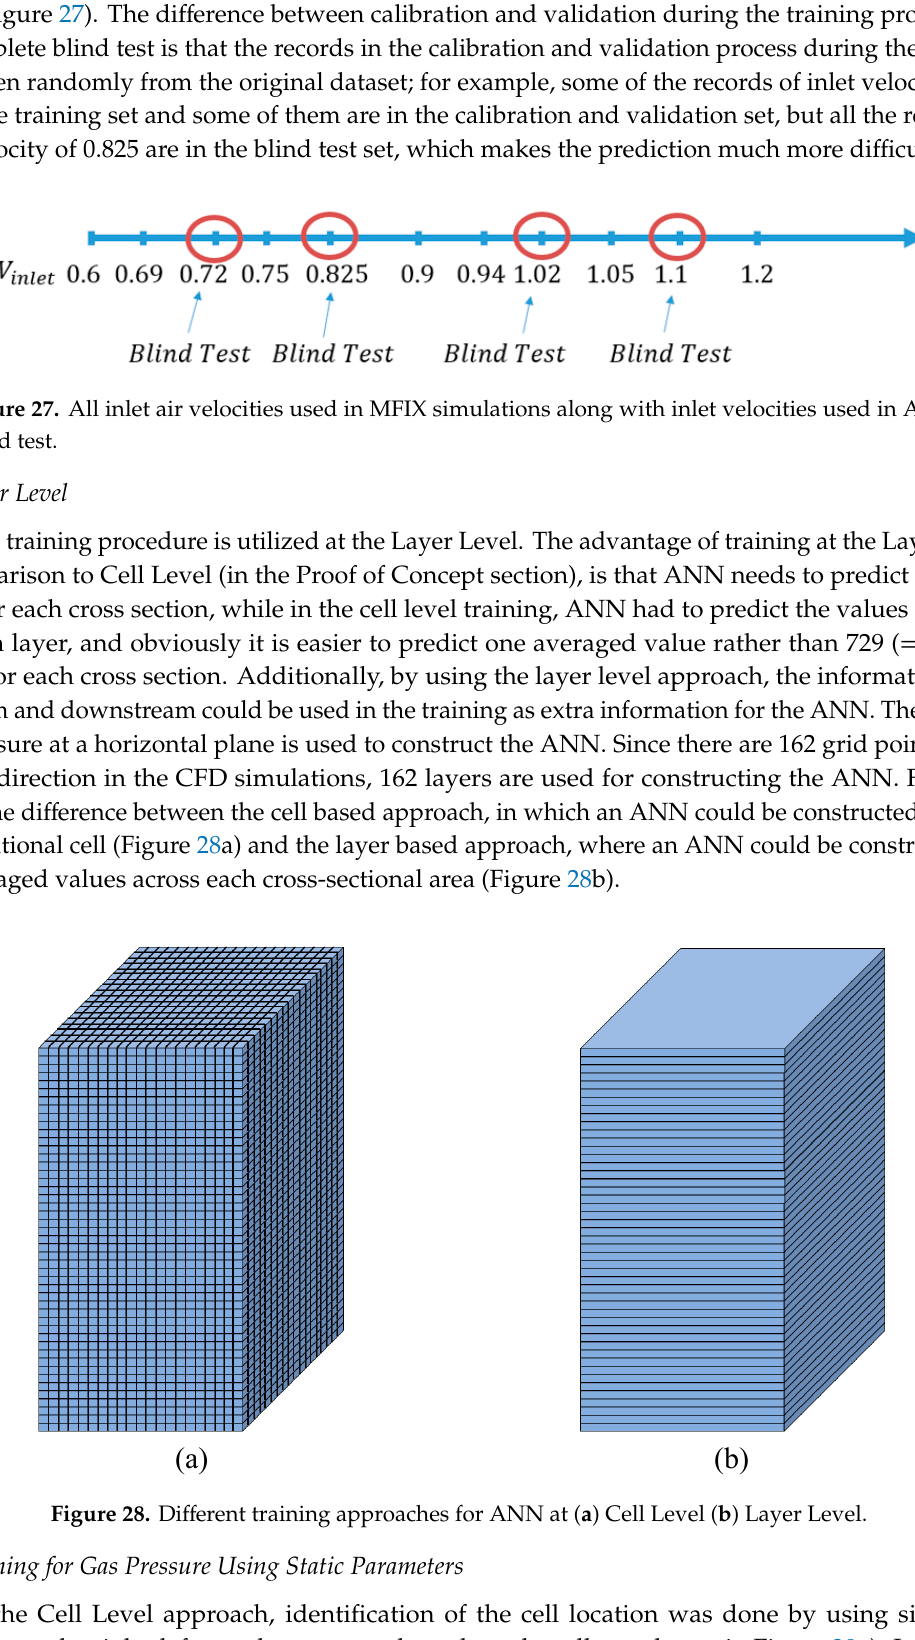
Figure 26. All inlet air velocities used in MFIX simulations along with inlet velocities used in ANN training.